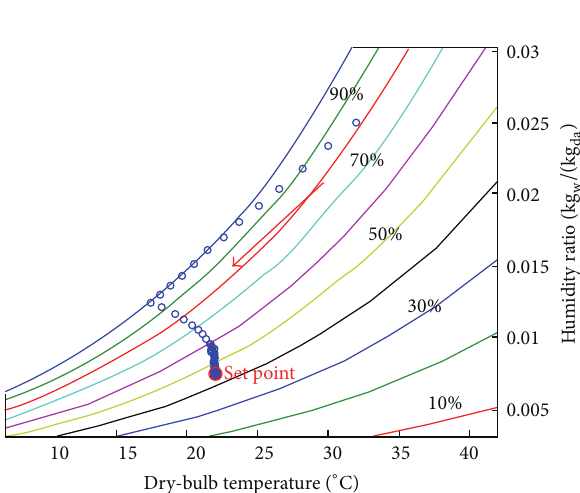
Figure 13: Zone air state change psychrometric